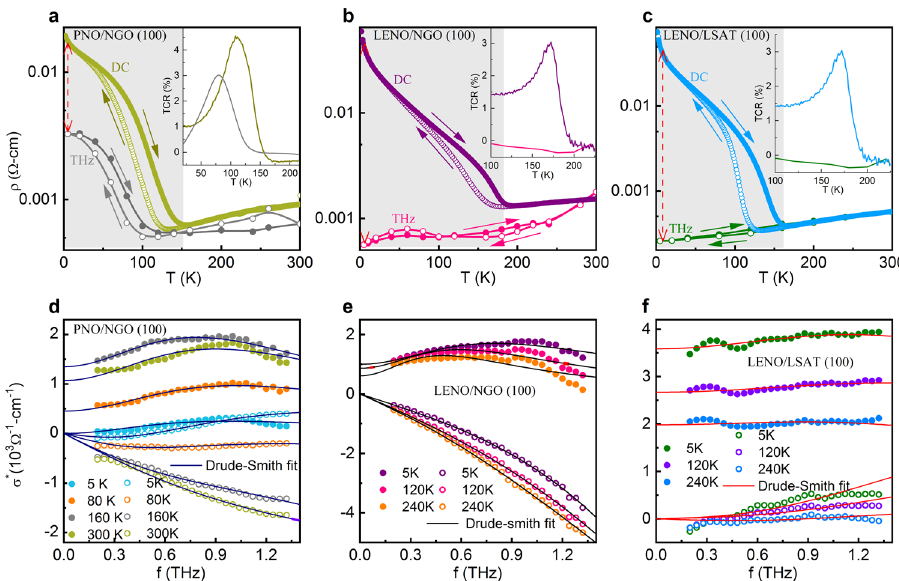
Fig. 1 Comparative representation of dc and THz resistivities as a function of temperature and THz frequency-dependent carrier dynamics. a – c Comparison of resistivities obtained from DC and THz transport (at 1 THz). The shaded region indicates the prominent difference between DC and THz ´ 100) plots in heating protocol. The temperature resistivities below the T MI . Insets show temperature coef fi cient of resistivity (TCR;TCR ð % Þ ¼ (cid:3) 1 ρ d ρ dT corresponding to maximum of TCR ð % Þ is the T MI of the fi lm. d - f Complex conductivity ( σ (cid:2) ) vs THz frequency spectra: the fi lled and void symbols represent the real ( σ 1 ) and imaginary ( σ 2 ) components of σ * , respectively. The solid lines are the fi tted curves using Drude-Smith